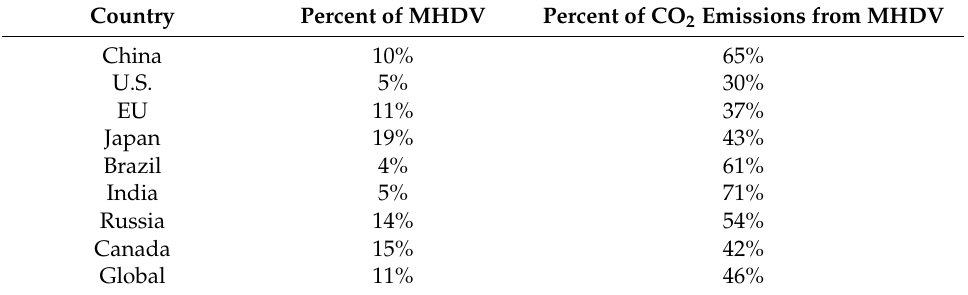
Table 2. Medium- and heavy-duty vehicle (MHDV) contributions to road transportation CO 2 emissions